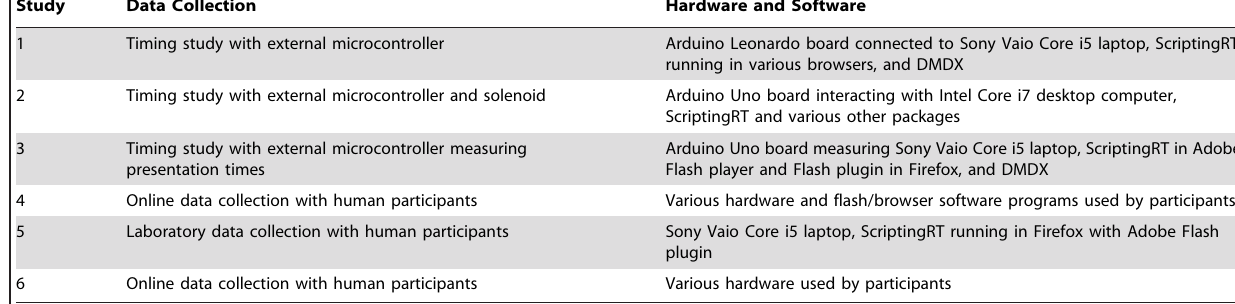
Table 2. Overview of the